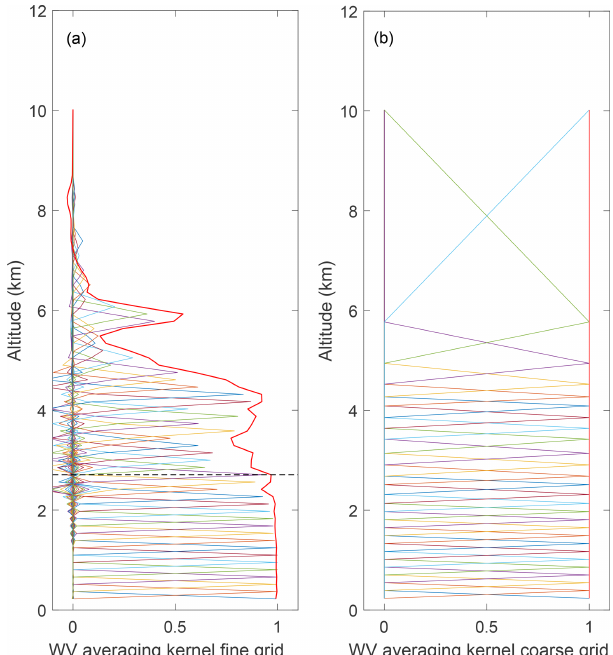
Figure 3. The clear-sky daytime water vapor averaging kernel ma- trix for 22 January 2013 at 12:00UT (a) on the fine grid and (b) on the coarse grid. Every other averaging kernel has been plotted for clarity. (a) The measurement response A u is the red solid line. The horizontal dashed line is the height at which the measurement re- sponse is first equal to 0.9 and is the line above which we would consider there to be large influence from the a priori. (b) The coarse- grid averaging kernels all equal 1 and reach up to the last retrieval altitude at